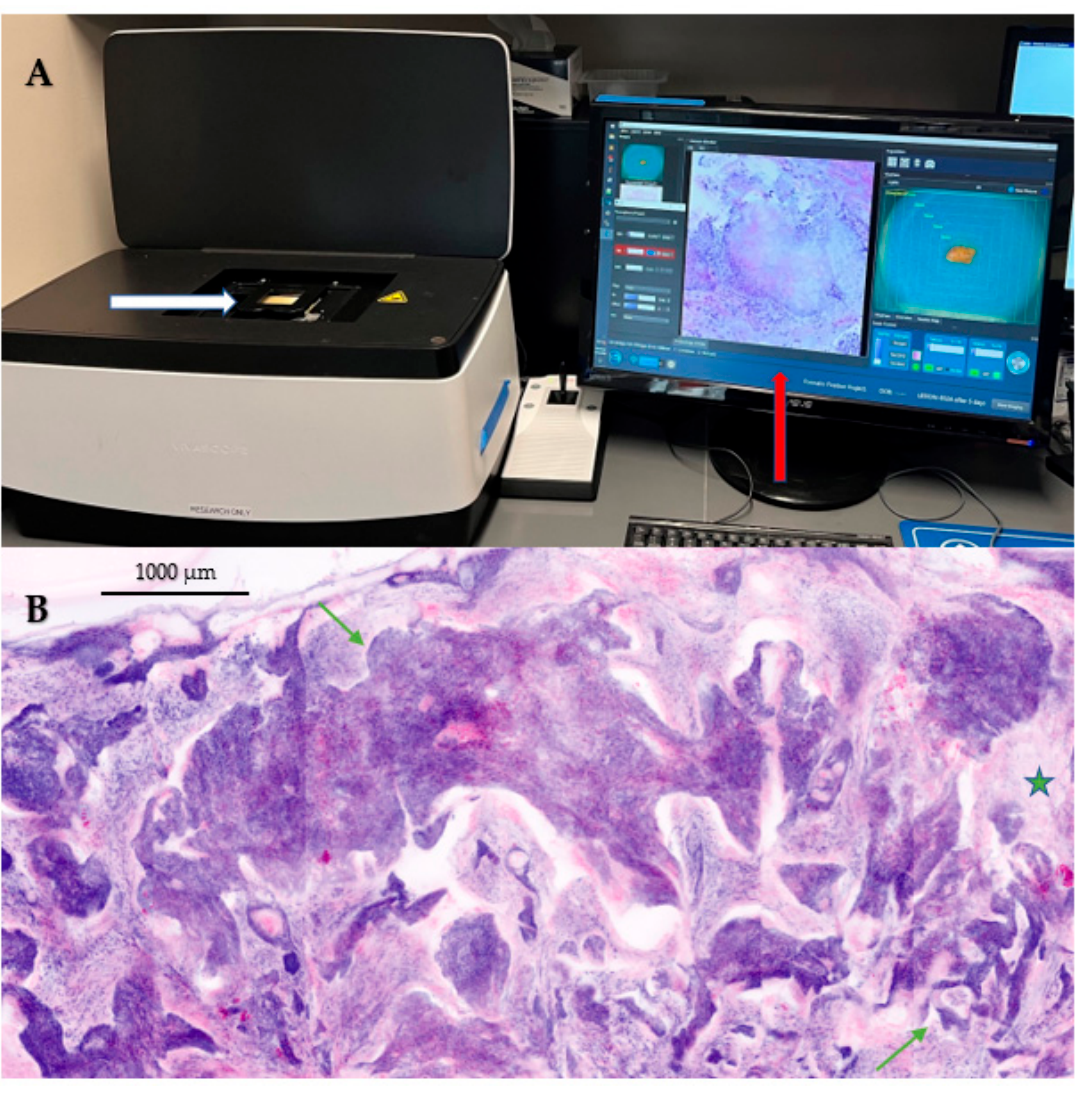
Figure 2. ( A ) An ex vivo confocal microscopy (EVCM) device with an attached computer screen for visualization of images in real-time. A fresh tissue from skin is mounted on a glass slide (white arrow) for imaging on the device and its digital hematoxylin and eosin (H&E) image (red arrow) is visible on the screen. ( B ) An EVCM image of a basal cell carcinoma in DHE mode showing nodular and infiltrative components (green arrows). Tumor nodules and cords appear purple due to fluorescent signals from nuclei, while stroma (green five-pointed star) appears pink due to reflectance signal, simulating H&E staining. Image A courtesy of Dr. Julia Kahn, Medical Graduate Student, Memorial Sloan Kettering Cancer